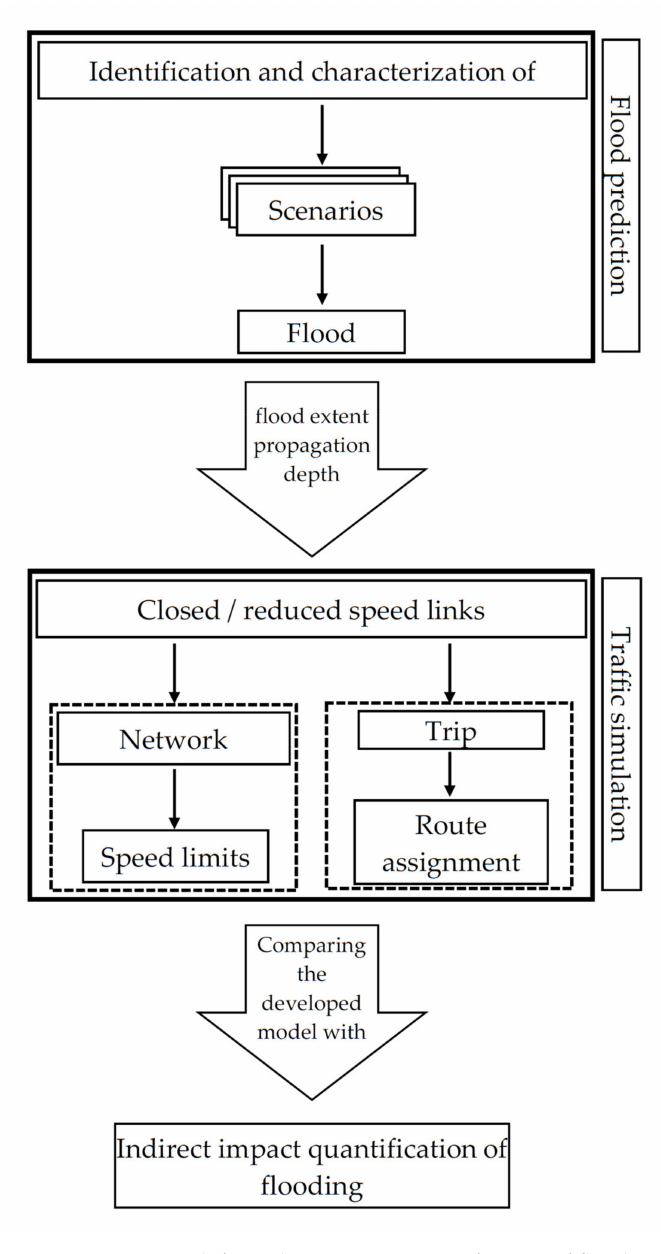
Figure 1. Framework for indirect impact quantification of